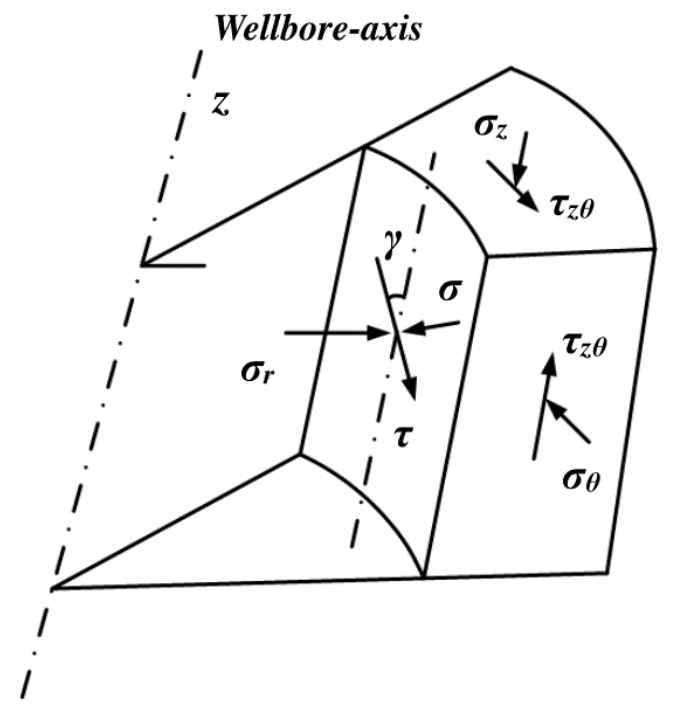
Figure 3. Schematic diagram of the stress distribution of the rock element on a deviated wellbore.